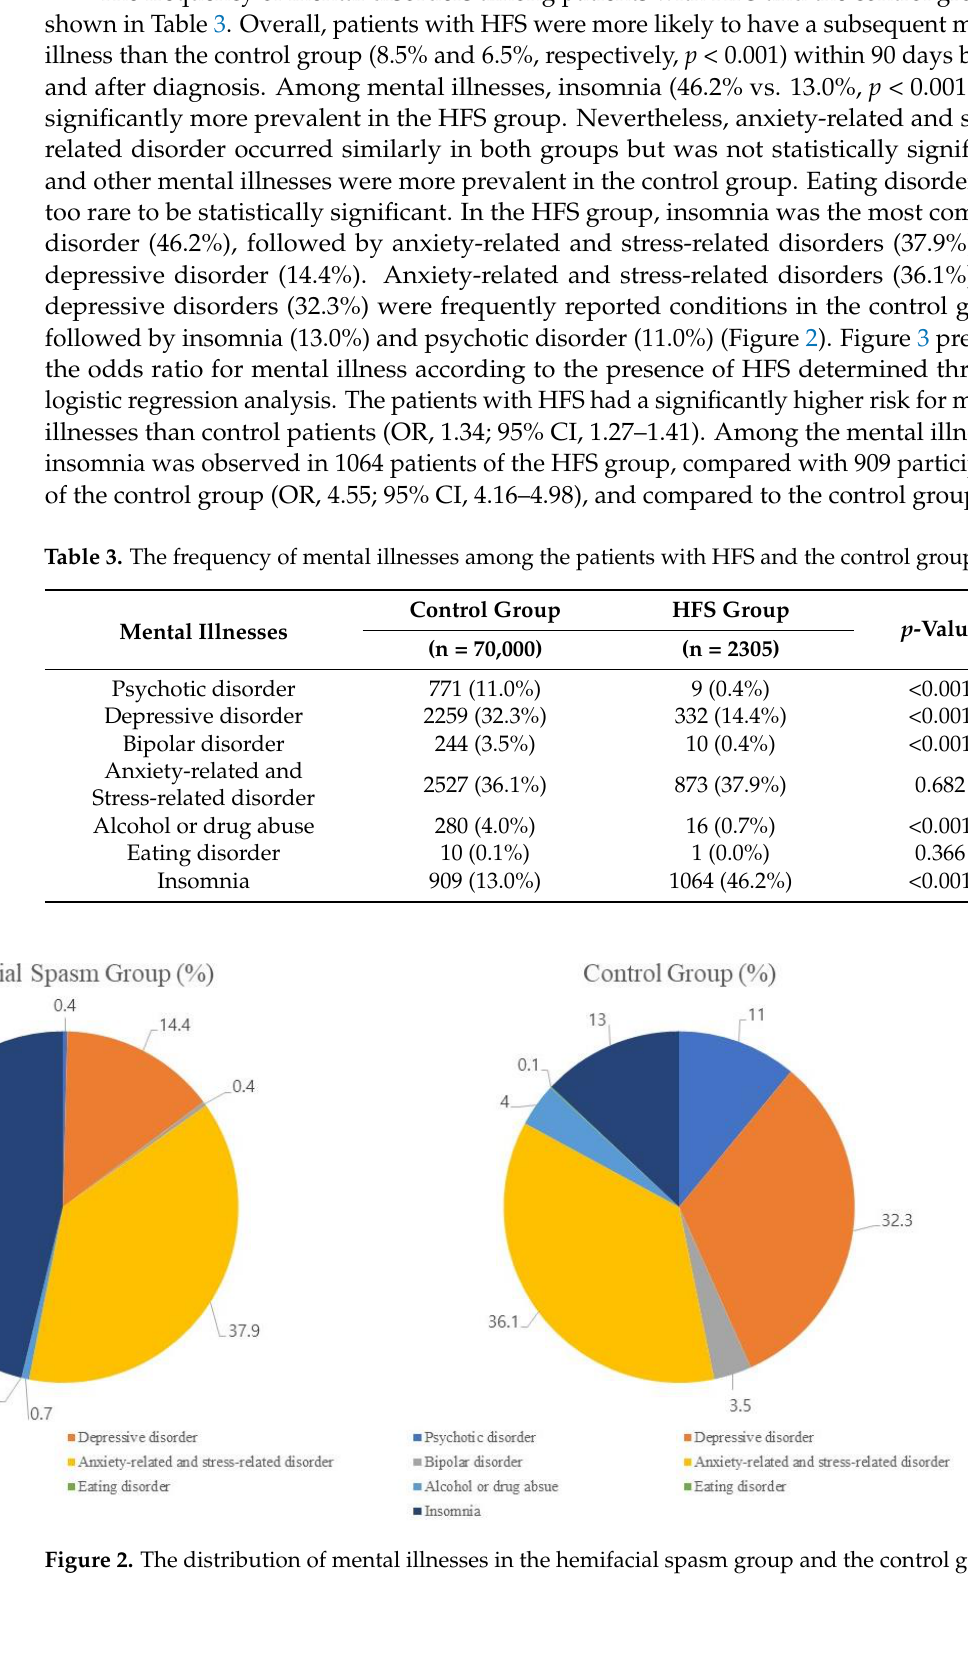
Figure 3. Propensity score-matched association of mental illnesses with hemifacial spasm . 4. Discussion Hemifacial spasm is a central nervous system disorder in which the muscles on one side of the face twitch involuntarily. As mentioned earlier, although HFS is not life-threat- ening, involuntary closure of the eyelids and twitching of the mouth can affect the quality of life of patients [9]. Some patients have even complained that their worst experience is social embarrassment due to facial disfigurement when interacting with strangers [4]. This problem may lead to low self-esteem and social isolation and, consequently, cause various mental illnesses. In a case-control study, Tan et al. reported that anxiety symptoms were significantly greater in patients with HFS than in healthy controls [6]. The authors also